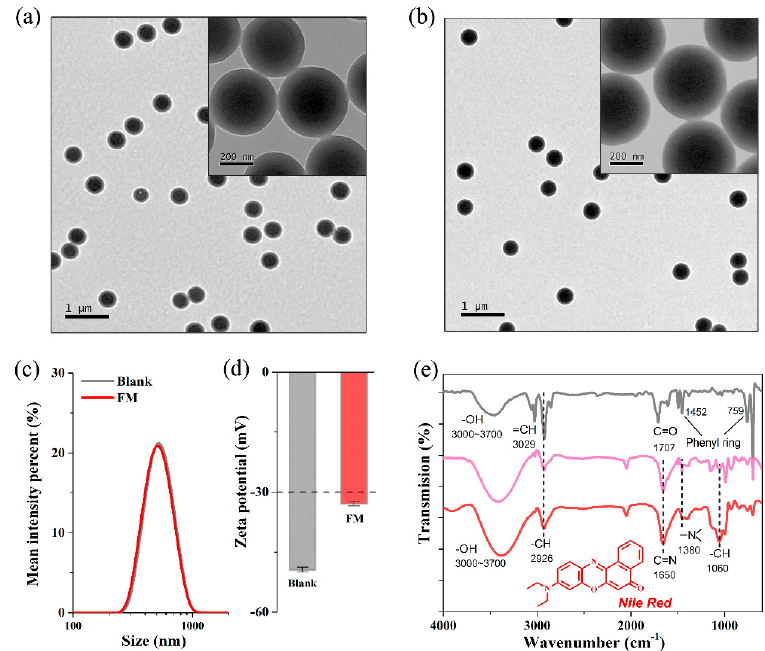
Figure 3. The TEM images of ( a ) blank microspheres and ( b ) fluorescent microspheres; ( c ) The particle size and ( d ) ζ -potential of blank and fluorescent microspheres (FM); ( e ) The FTIR spectrum of blank microspheres (grey line), NR (pink line) and fluorescent microspheres (red line).